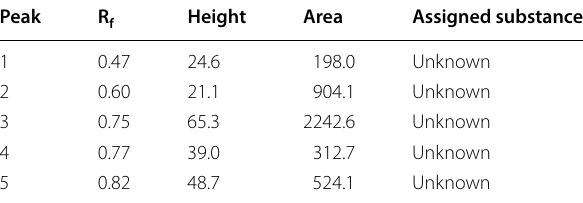
Table 10 Peak table of BPSAL in mobile phase III Peak